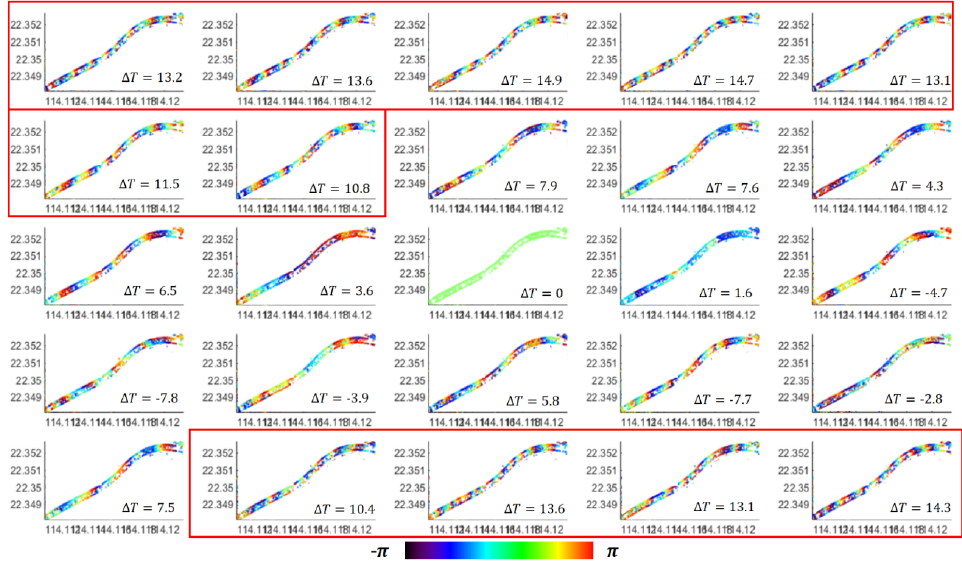
Figure 14. The time series differential interferograms of the TKH, the red rectangles indicate the differential interferorgrams with larger temperature differences and denser fringes.